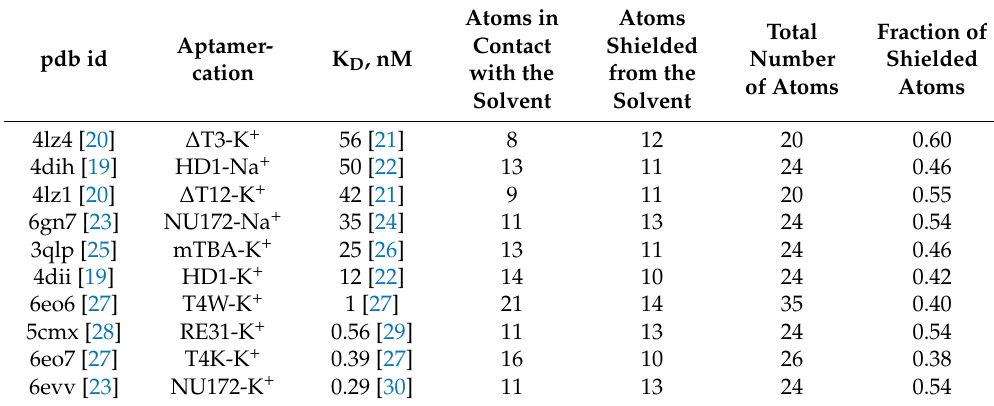
Table 1. The solvent accessibility of the non-polar cores of recognizing loops of the G-quadruplex- based aptamers in the complex with thrombin. Aptamer- pdb id